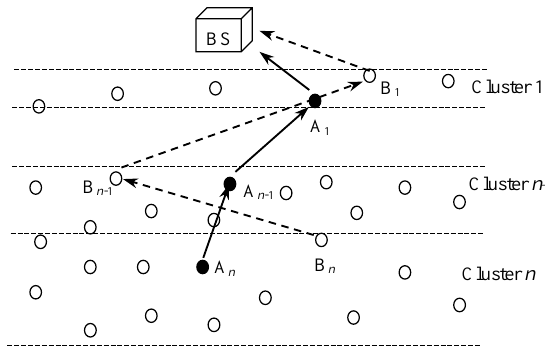
Figure 5. Significance of total path connecting all CHs instead of individual paths from CHs to the